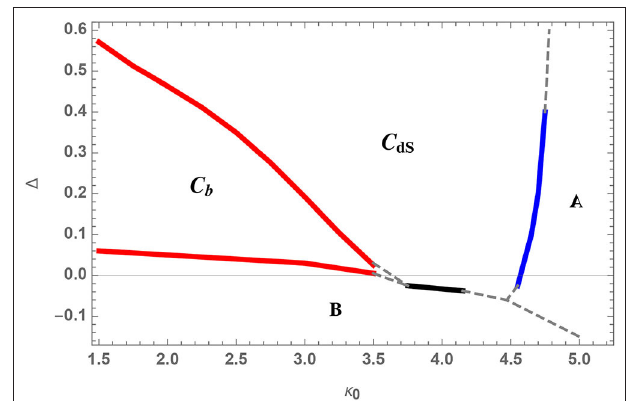
FIGURE 1 | The CDT phase diagram. Phase transition between phase C dS and C b is (most likely) second order, as is the transition between C b and B , while the transition between C dS and A is first order. The transition between C dS and B is still under investigation, but preliminary results suggest a first-order